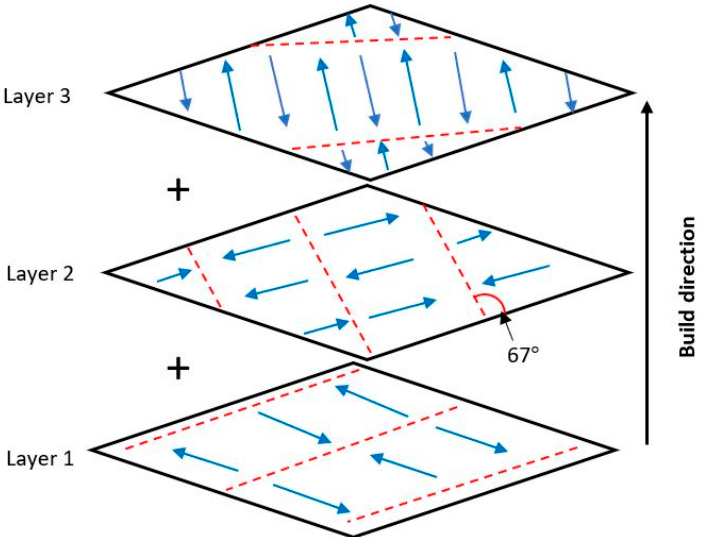
Figure 1. Schematic diagram illustrating the EOSINT M280 machine scanning strategy employed in production of samples for use in this study. The arrows show the scan vectors in every stripe (shown by the dashed lines). The stripes in the subsequent layer are rotated at 67° from the previous layer.